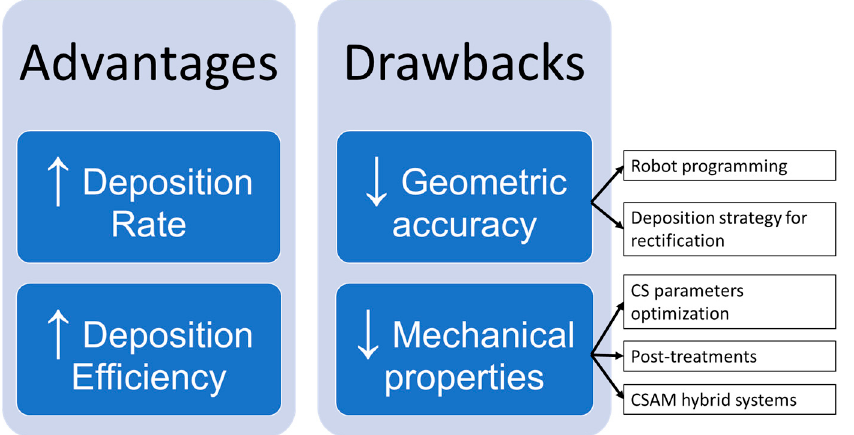
Figure 6. CSAM advantages and drawbacks, and the alternatives presented in the literature to over- come them. overcome